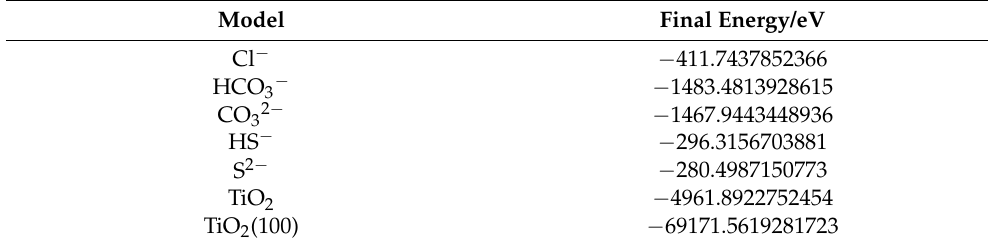
Table 4. The final energy of five ions, TiO 2 , and TiO 2 (100).